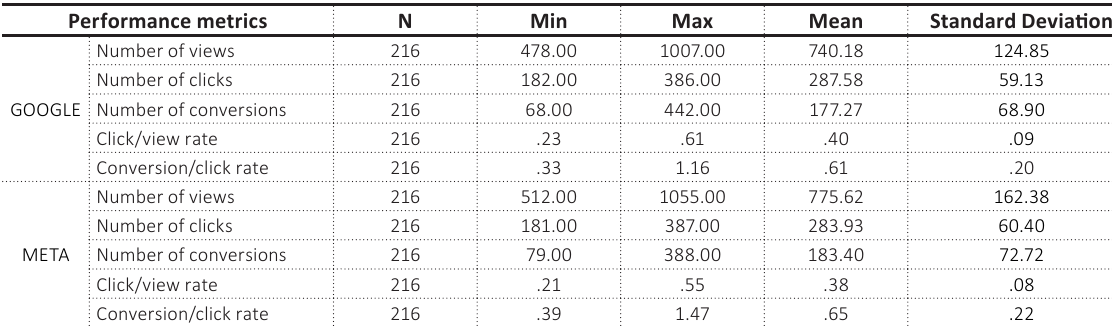
Table 2. Summary statistics for the 2021 data set Performance